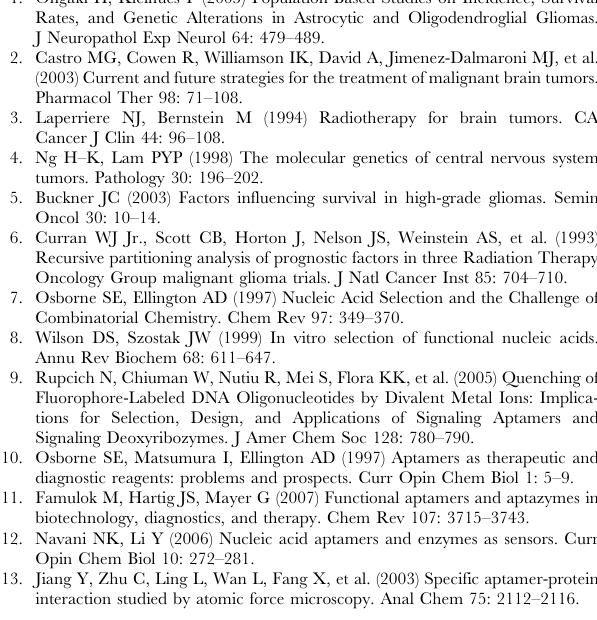
Figure S5 Using aptamer GBM131 to recognize differ- ent FFPE caner tissues. Different FFPE tissue sections were incubated with cy5-labeled aptamer GBM131. A = Brest cancer tissue; B= Renal cell carcinoma tissue 8; C= Medulloblastoma tissue; D= Hepatocellular carcinoma tissue; E= Small cell lung cancer tissue; F = Cervical squamous cell carcinoma tissue; G= Pituitary adenomas tissue; H= Acoustic neuroma tissue; I= Ependymoma tissue; J= Craniopharyngioma tissue; K = Glio- blastoma tissue. The final concentration of Cy5-labeled aptamers was 250 nM. Table S1 Specificity of aptamer candidates. Selectivity study of selected aptamers to different cell lines